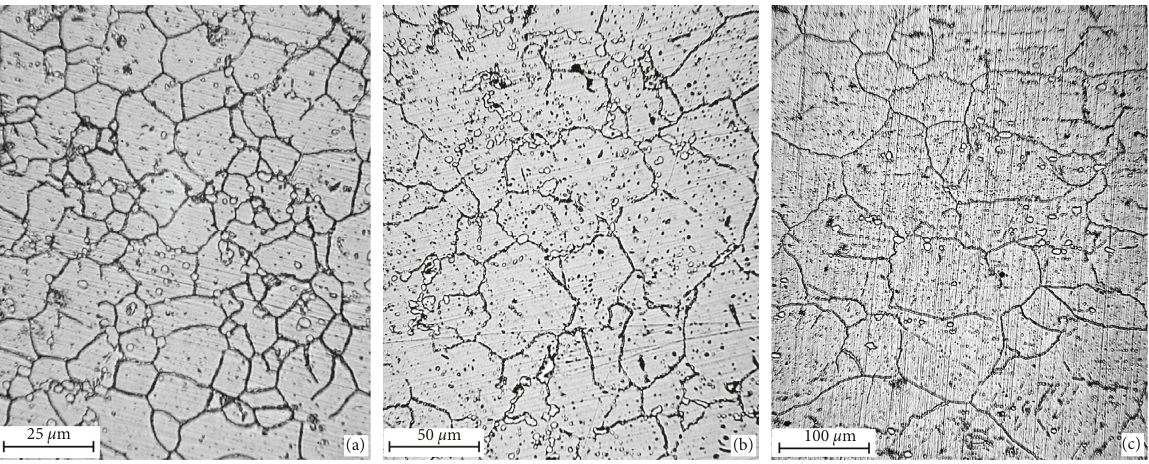
Figure 6: Microstructure of the alloy: after VAR and HT II (a), HT I (b), and HT IV (c). Table 3: Mechanical properties of alloys with different chemical composition at 293K and displacement rate 0.1mm/min.